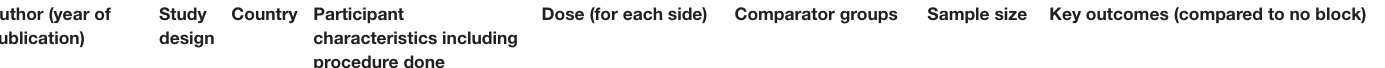
Ultrasound guided lumbar erector spinae plane (ESP) block vs. conventional opioid based multimodal post-operative